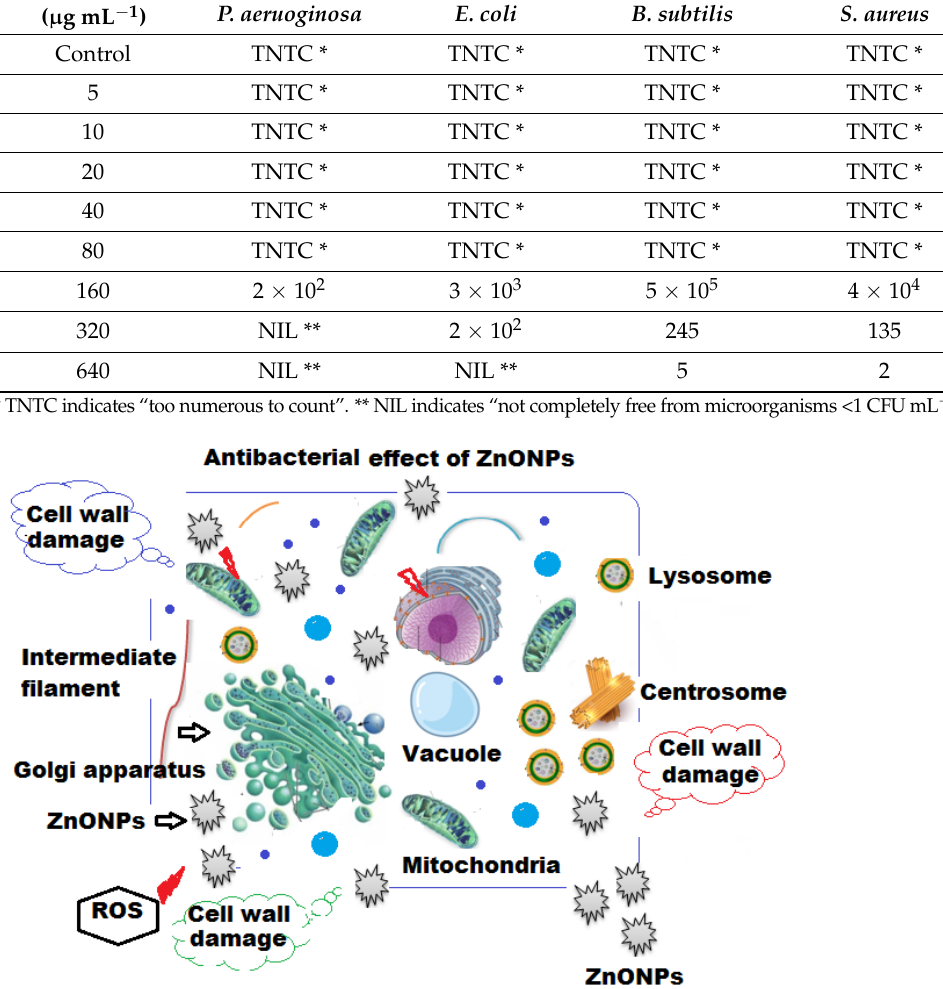
Figure 9. The possible mechanism of antibacterial effect of green synthesized ZnONPs using oat biomass against the bacterial cell. Table 2. Least bactericidal potential of ZnONPs synthesized using oat biomass on P. aeruginosa , E. coli, B. subtilis and S. aureus.